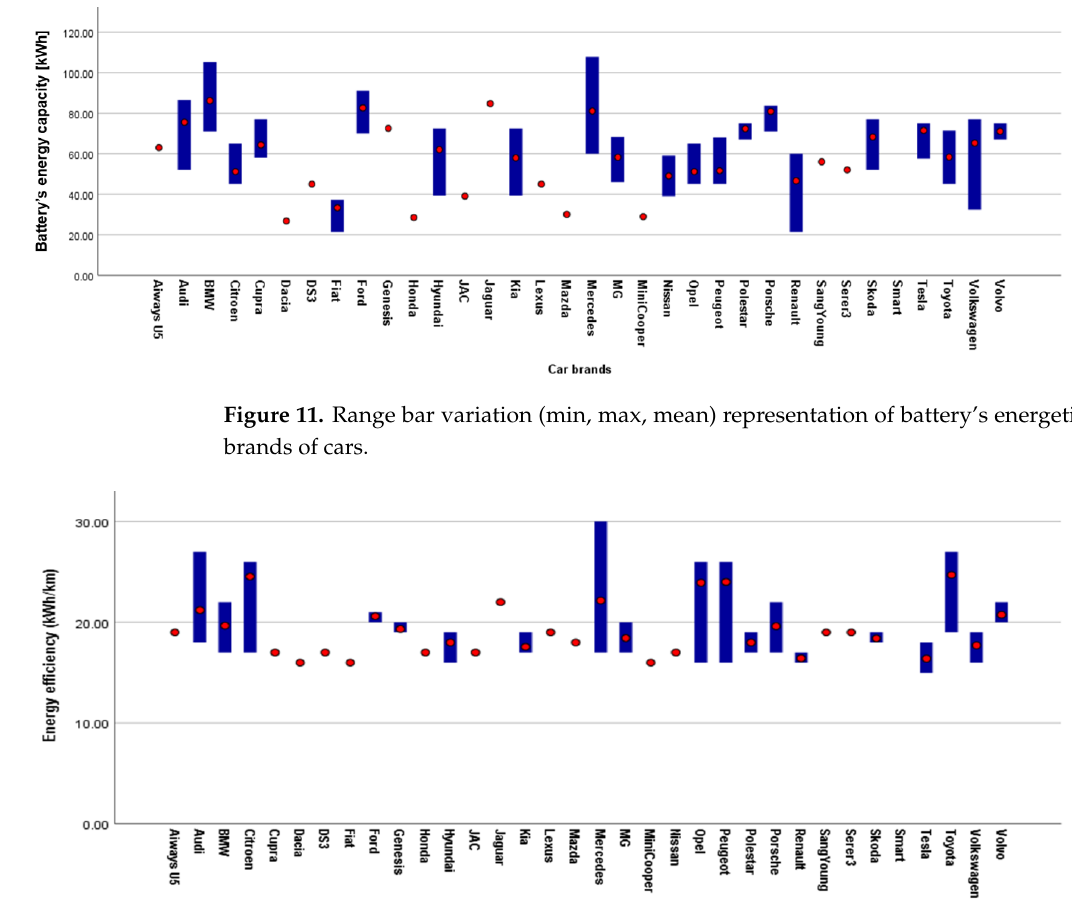
Figure 10. Range bar variation (min, max, mean) representation of autonomy vs. brands of cars.